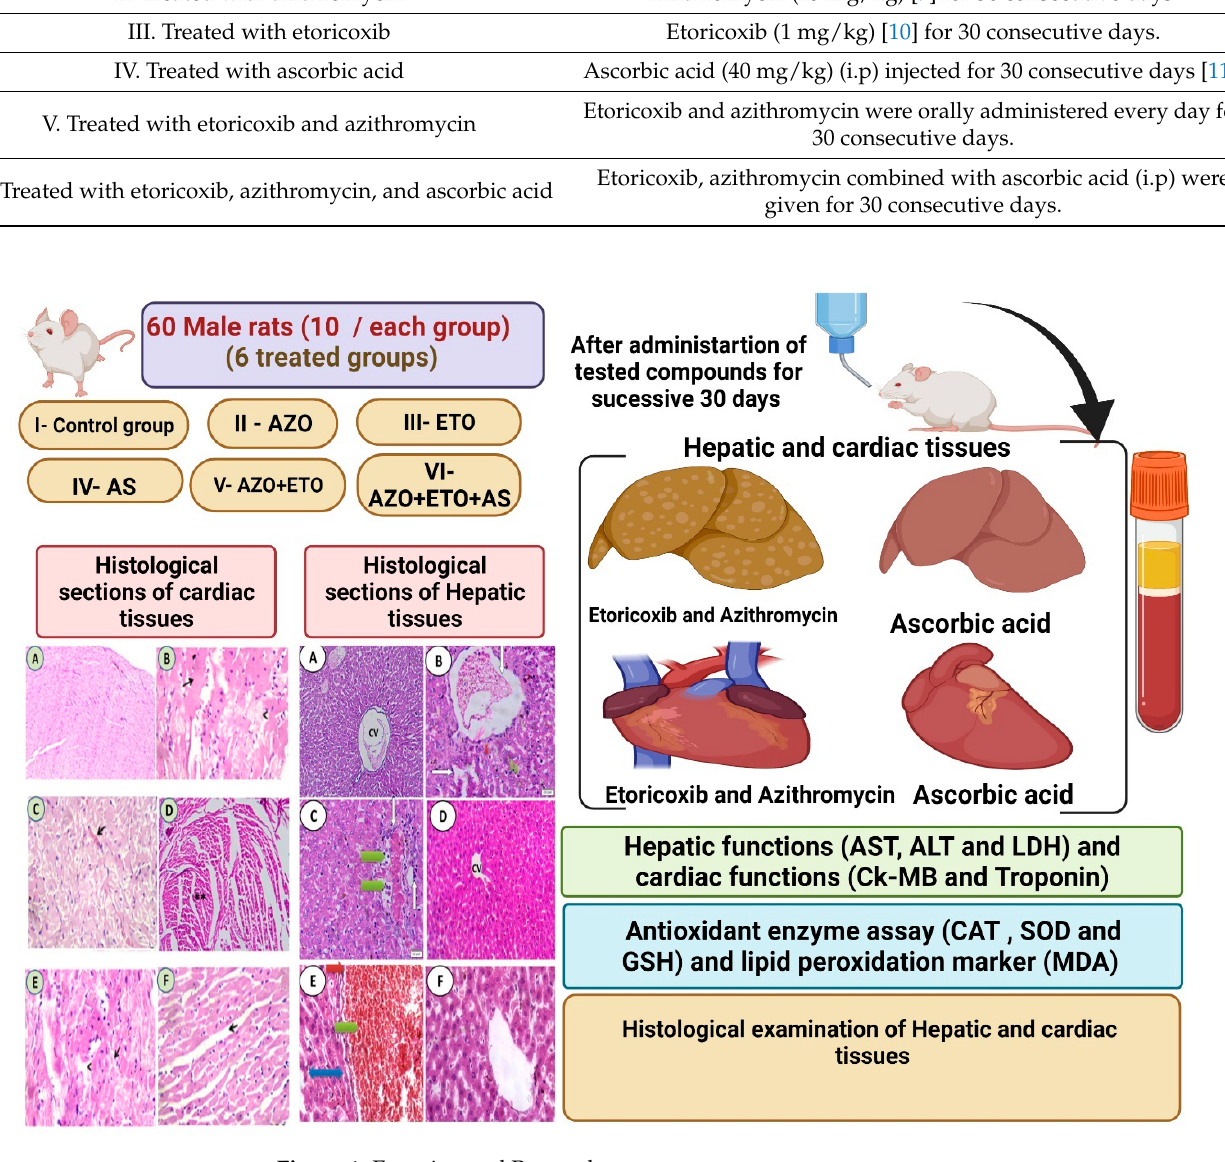
Figure 1. Experimental Protocol. Table 1. Compounds of